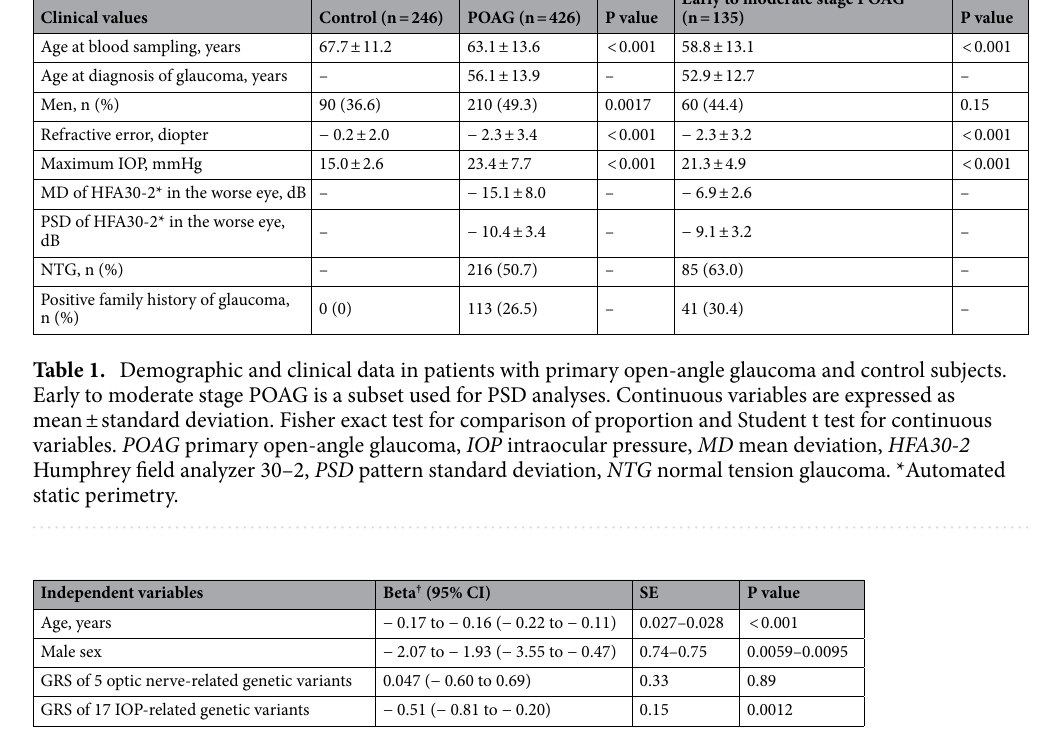
Table 2. Results of a multiple linear regression analysis with mean deviation of automated static perimetry* in the worse eye as a dependent variable in patients with primary open-angle glaucoma. CI confidence interval, SE standard error, GRS genetic risk score, IOP intraocular pressure. *Humphrey field analyzer 30–2 (HFA30- 2), † Regression coefficient. F change = 13.1–17.0, P <